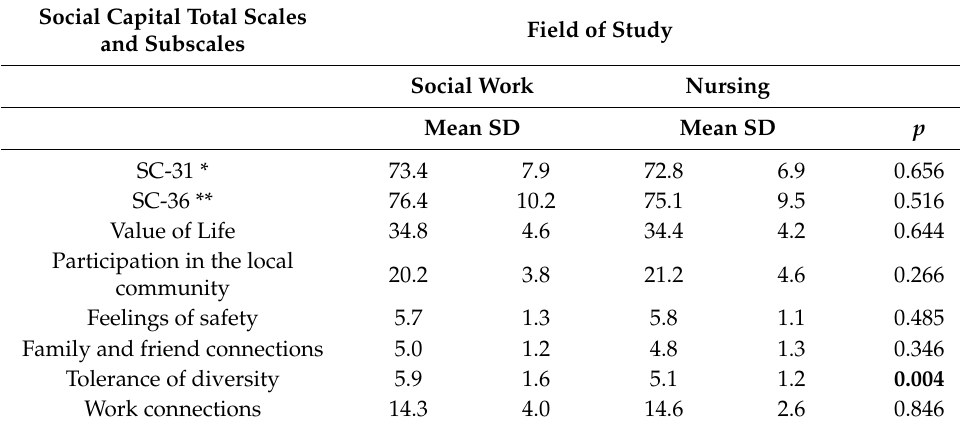
Table 4. Social capital differences between fields of study.